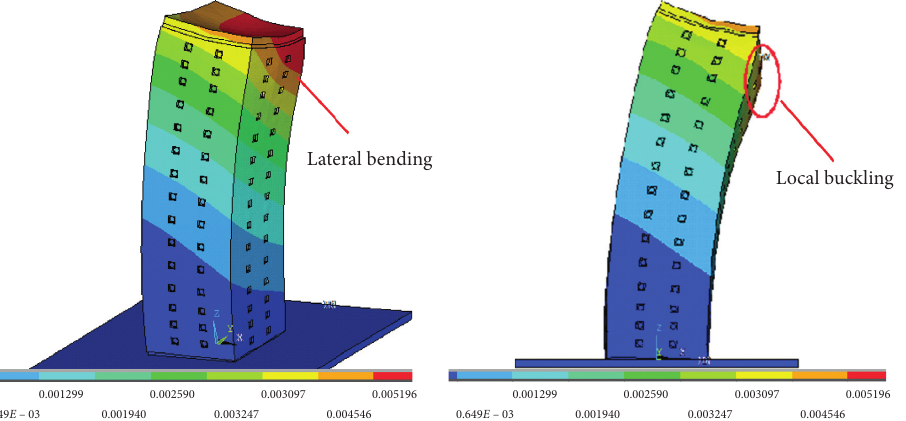
Figure 11: Cloud pictures of holistic displacement.